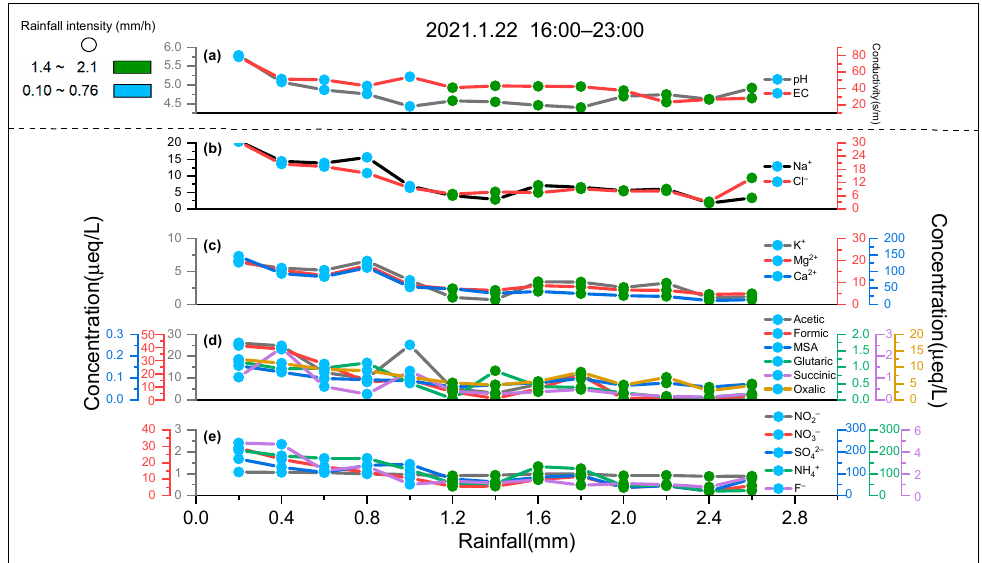
Figure 2. The change patterns of water-soluble ions in rainfall event with rainfall intensity and